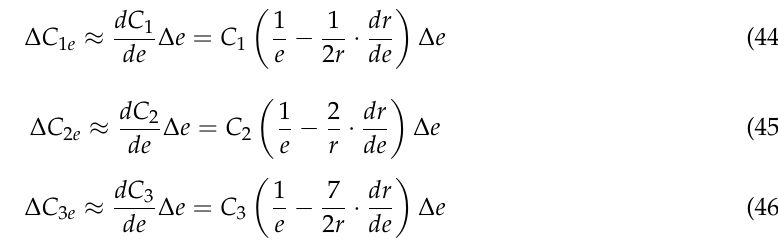
e   . According to Figure 3b, e  has a secular variation, and the annual